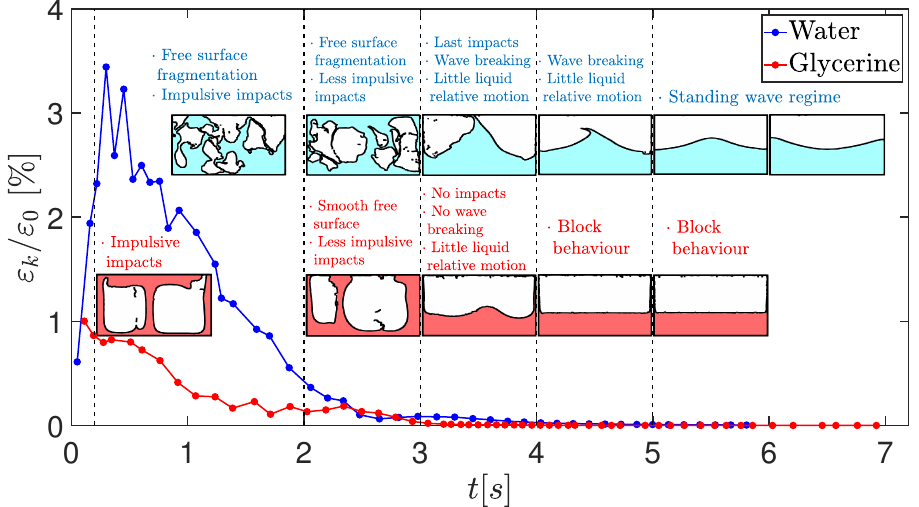
Figure 7. Normalized amplitude of the relative kinetic energy of the liquid. Comparison between water and glycerine.